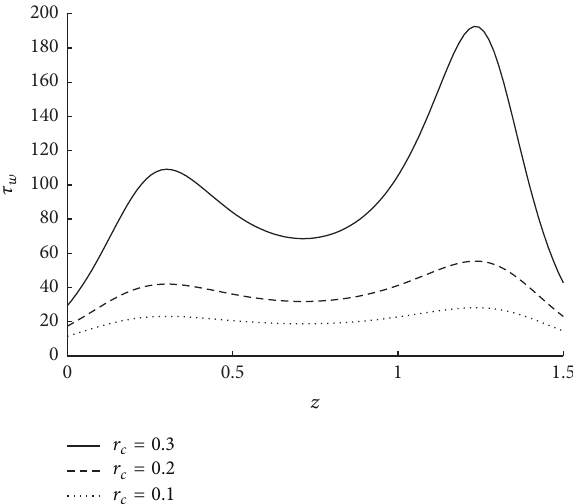
Figure 16: The variation of shear stress at wall in stenosed region with respect to 𝑟 𝑐 when 𝑁 = 0.75 , 𝜖 = 0.1 , 𝑢 = 0.01 , 𝑚 = 10 , and 𝜙 = −0.05 .